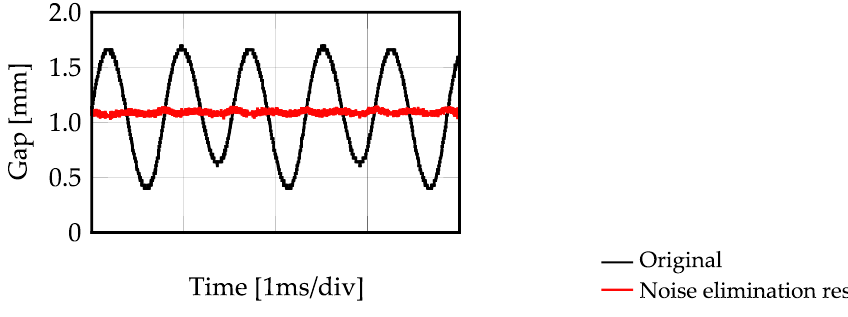
Figure 24. Time–history of gap in the steady state when the secondary circuit is closed.